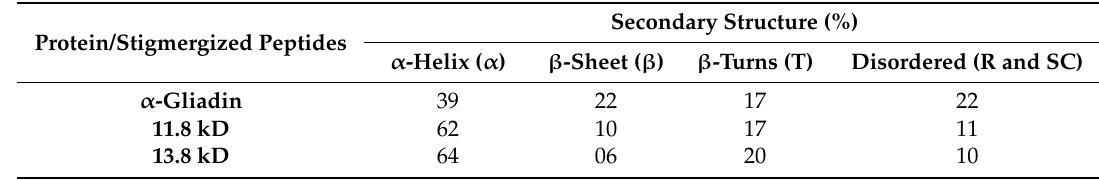
Table 2. Predicted secondary structure of stigmergized